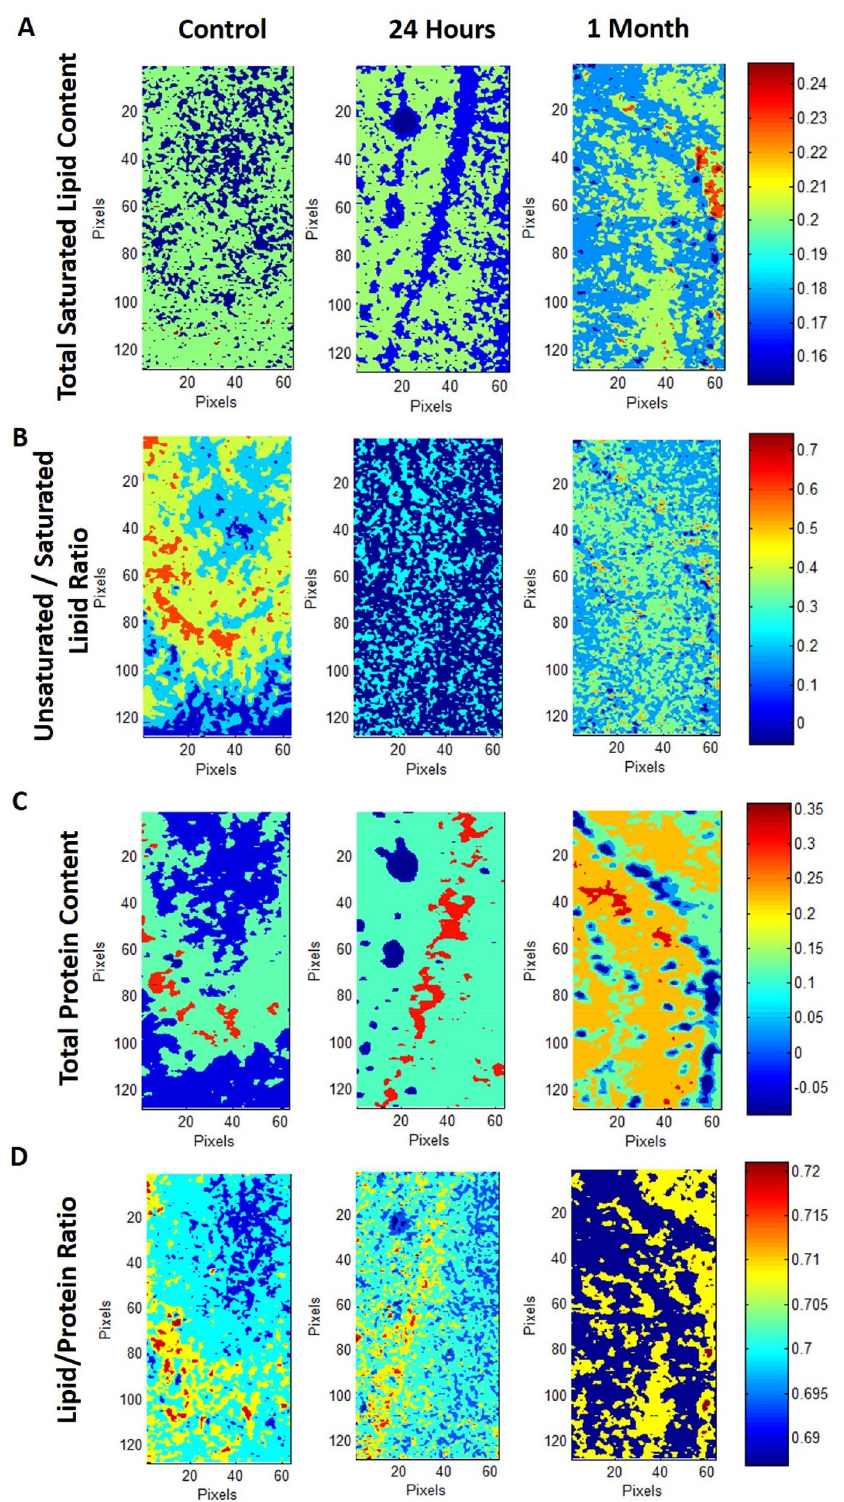
Figure 5. Typical FTIR images of total saturated lipid content ( A ), unsaturated/saturated lipid ( B ), total protein content ( C ), lipid/protein band area ratios in right hippocampal tissue of control, 24 h and 1-month TBI groups. Color bars represent the scales for each of the parameters. Axes are in pixels, where one pixel is 6.5